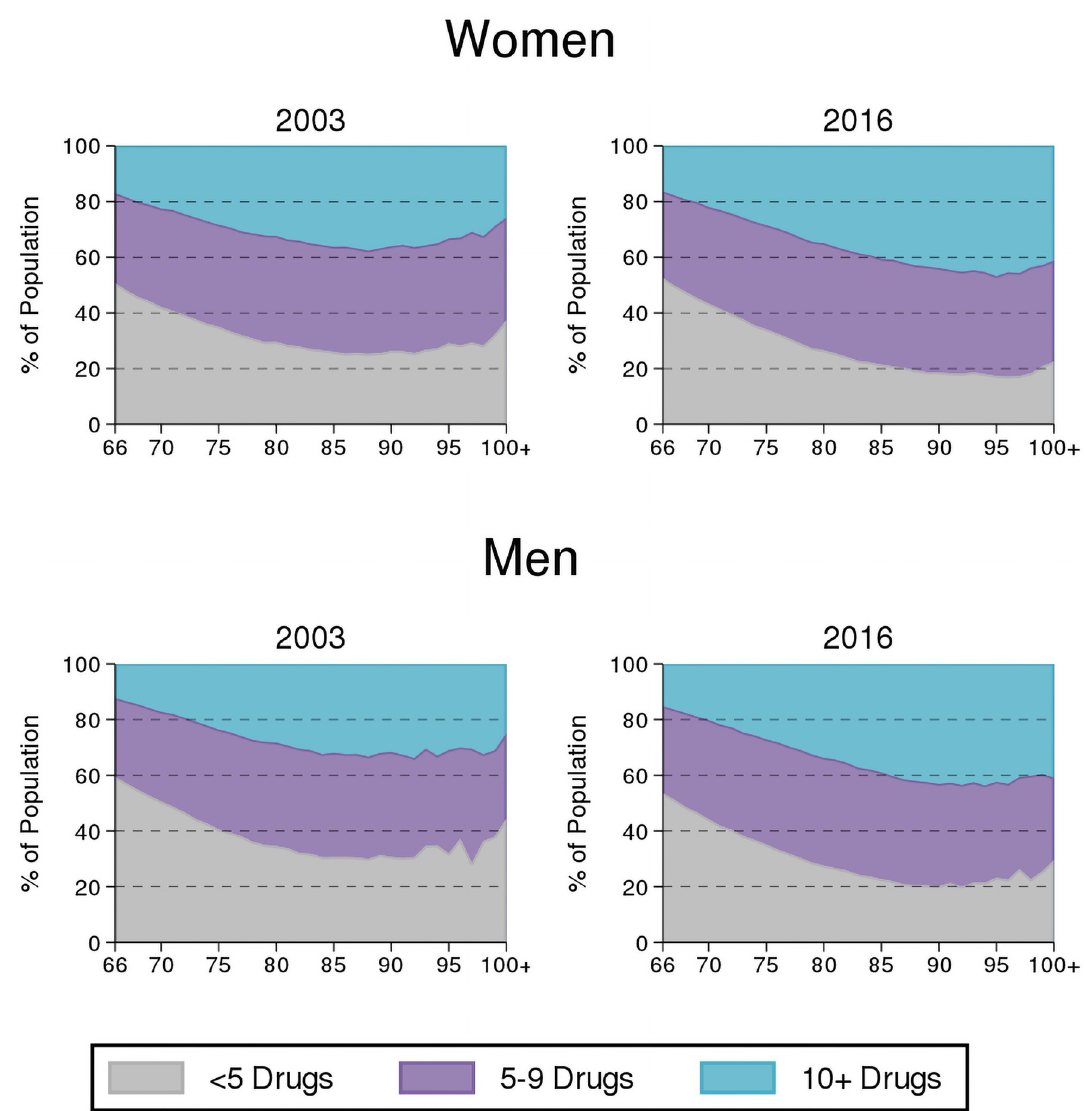
Fig 2. Distribution of polypharmacy and hyper-polypharmacy by age among older adults (age � 66 years) in Ontario, Canada: 2003 vs 2016 for women and men. use of non-steroidal anti-inflammatory drugs (NSAIDs) and benzodiazepines (BZDs) among men and women with polypharmacy and hyper-polypharmacy. There was also a decline in the use of bisphosphonates in women and coronary vasodilators in men. Among both sexes with hyper-polypharmacy, significant proportions were receiving statins (76% men, 64% women),